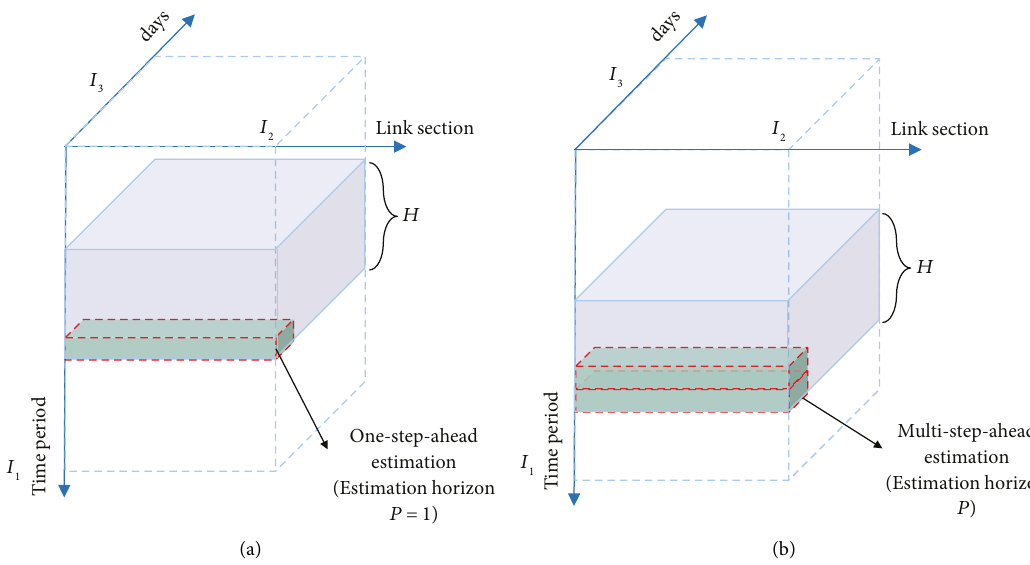
Figure 3: Example of the dynamic tensor with traffic speeds to be estimated. (a) One-step ahead estimation; (b) multistep ahead